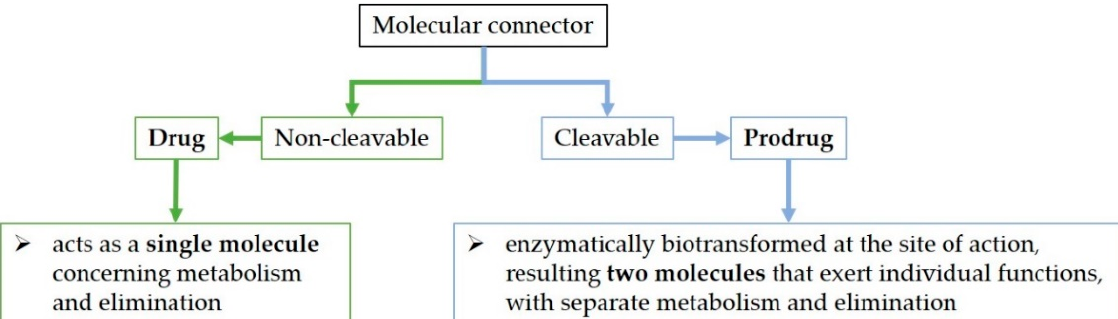
Figure 6. The drug versus prodrug approach.